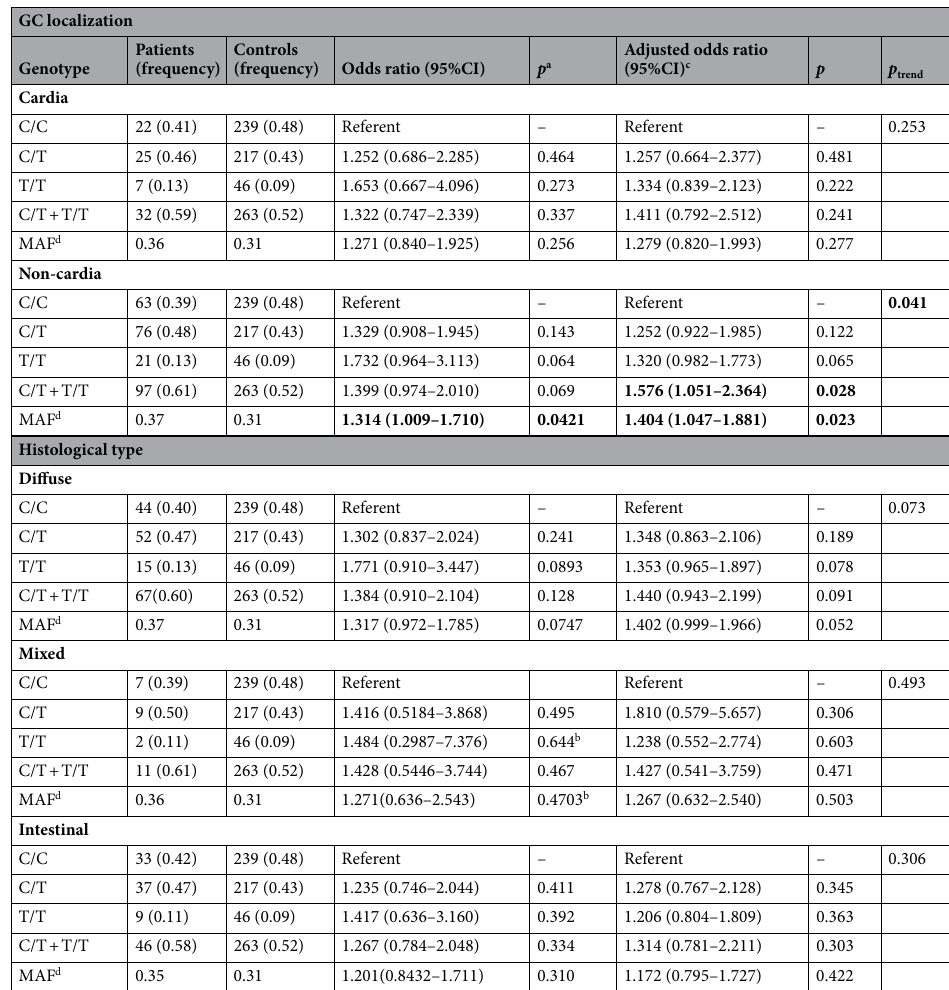
Table 3. Prevalence of the CCAT1 rs67085638 polymorphism among localization of GC and histological type of GC. The number of patients with undetermined histological type GC [(C/C-1 (0.17); C/T-3 (0.50): T/T-2 (0.33)] was too small; therefore, we did not apply statistical logistic regression. Significant results are highlighted in bold font. a χ 2 or b Fisher’s exact test. c ORs were adjusted by age, BMI and presence of diabetes. d Minor allele